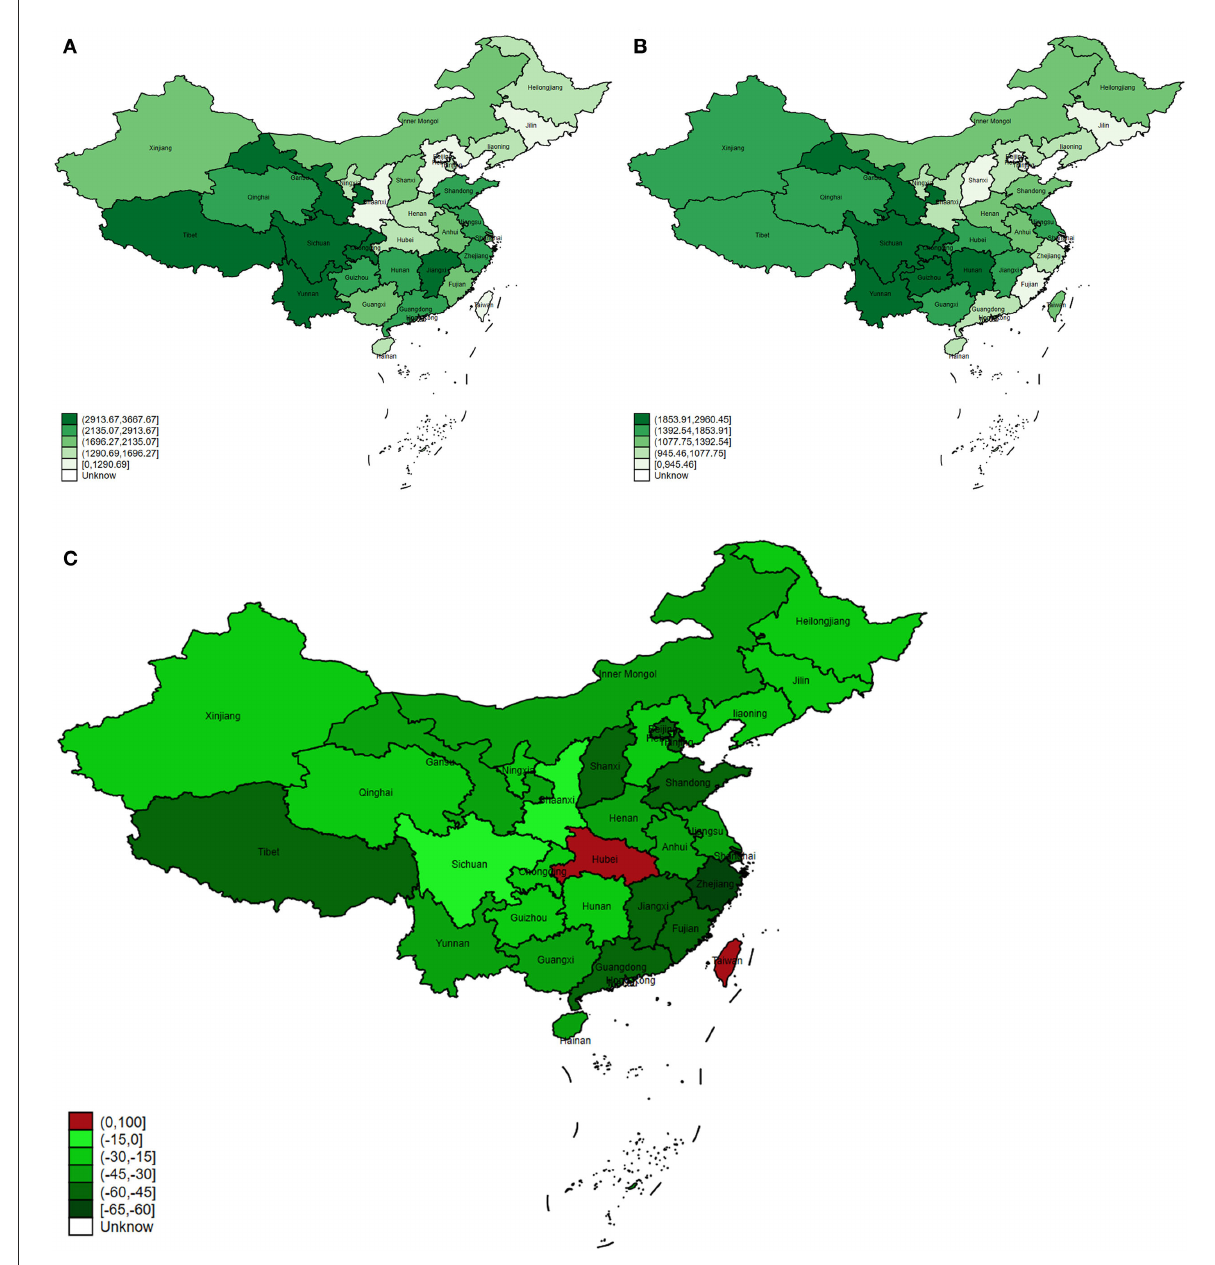
FIGURE2 The trend of ASR of COPD DALY in China and its provinces. (A) The ASR of COPD DALY in China and its provinces in 1990. (B) The ASR of COPD DALY in China and its provinces in 2017. (C) The change of ASR in China and its provinces from 1990 to